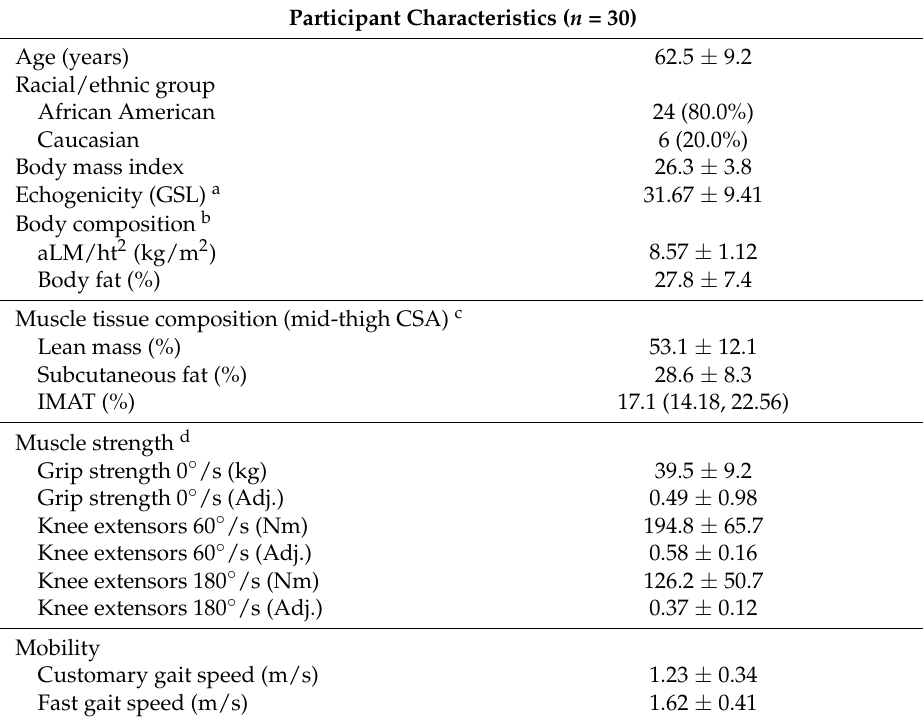
Table 1. Participant